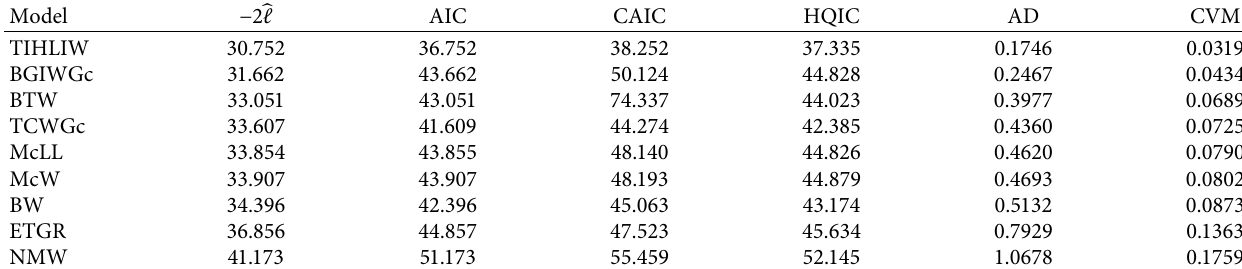
Table 4: Goodness-of-fit measures for relief times data.